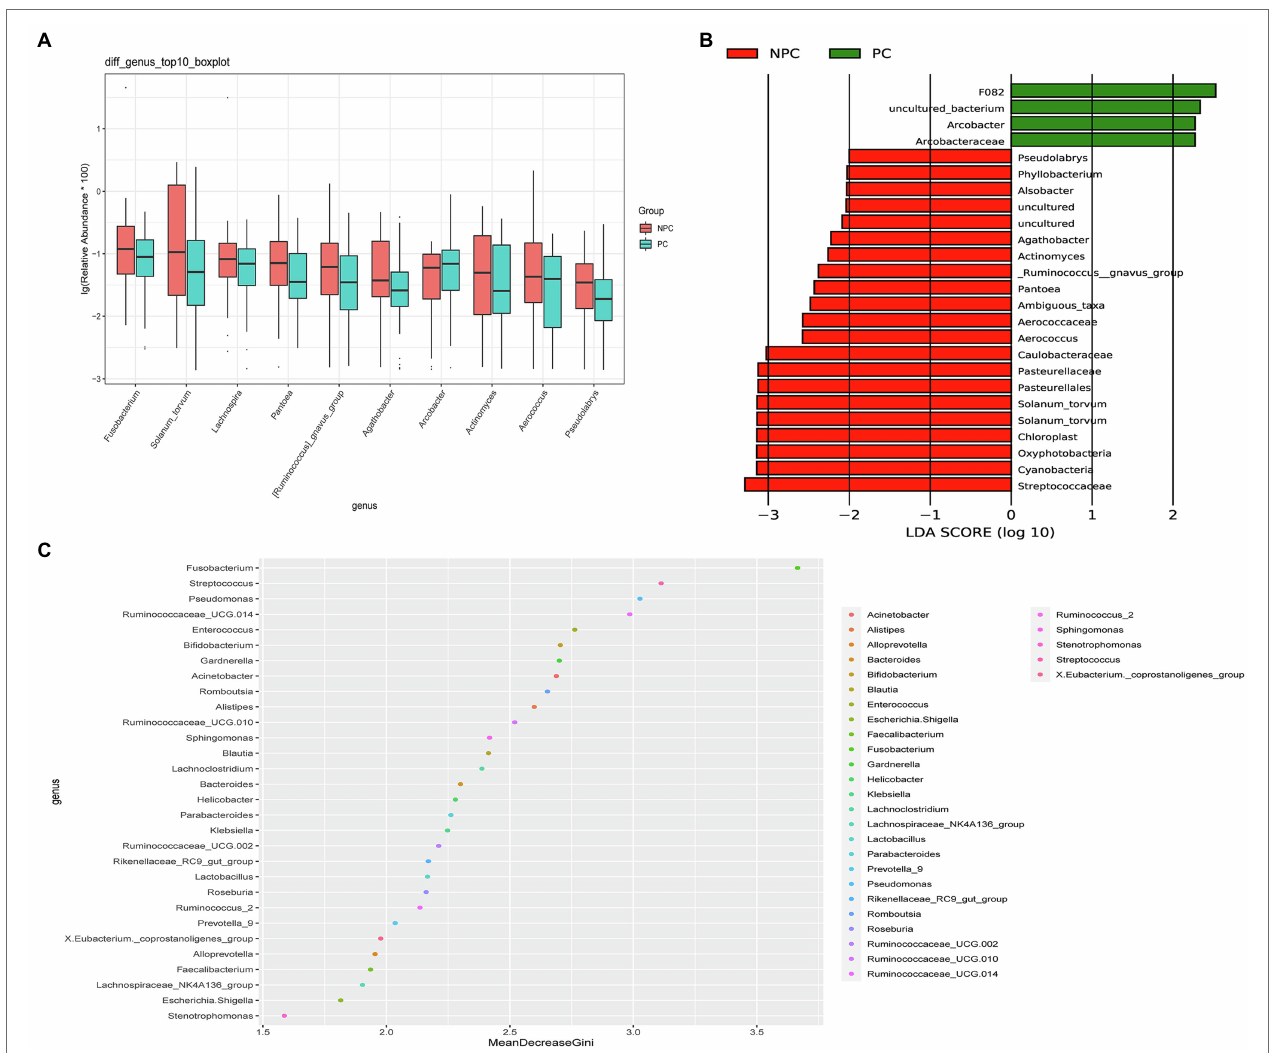
FIGURE 9 | Differences in the cervical microbiota between pregnant and non-pregnant groups. (A ) Boxplot of the top 10 genera in the sdifferential genera between the two groups. (B) Linear discriminant analysis to find potential genera contributing to intergroup differentiation. The green bar indicates the genera contributing to the pregnant group, while the red bars indicate the genera contributing to the non-pregnant group. (C) Random forest analysis for mapping genera importance points. The horizontal coordinate is the importance measure, and the vertical coordinate is the name of the genera after ranking by